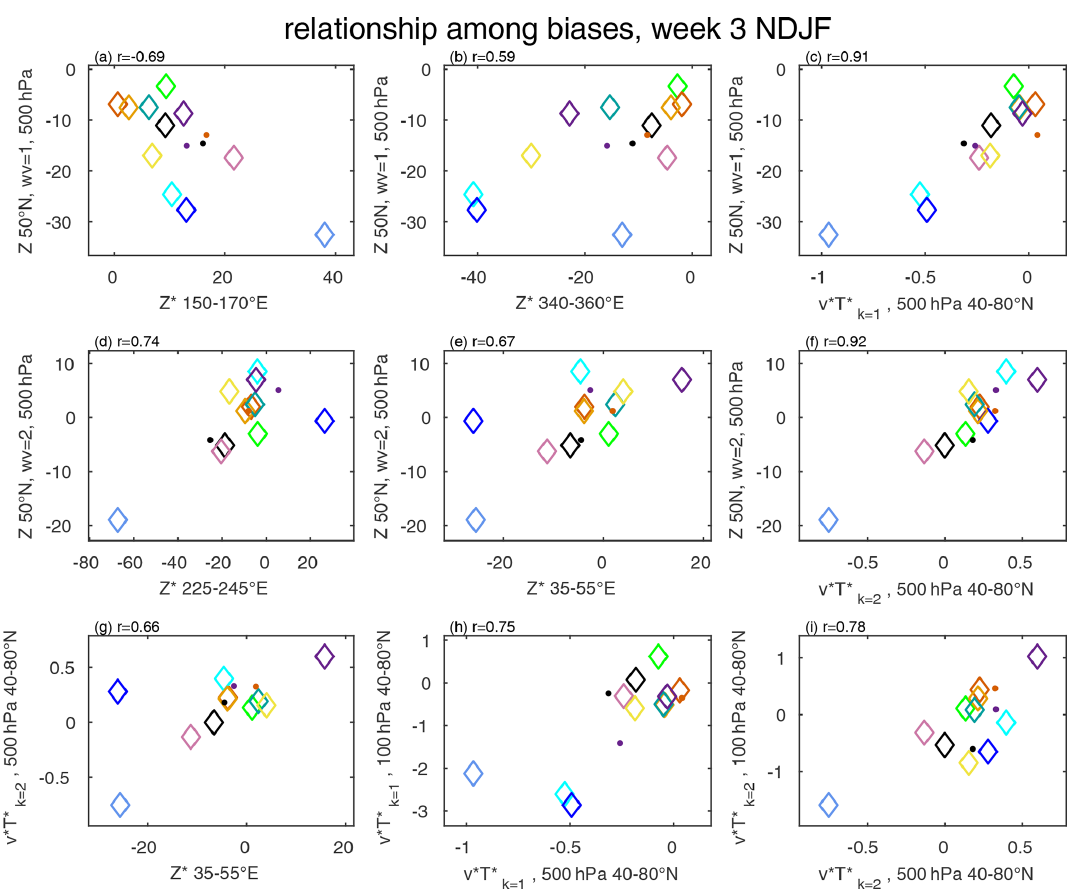
Figure 6. Summary of relationships among the biases in the S2S models during NDJF (the different models are represented by colors similarly to the legend of Fig. 3). Panels (a)–(c) : Z at 50 ◦ N wavenumber 1 and (a) 500hPa Z ∗ over the northwestern Pacific (150–170 ◦ E), (b) 500hPa Z ∗ over the North Atlantic (340–360 ◦ E), and (c) 500hPa mid-latitude (40–80 ◦ N) wavenumber 1 v ∗ T ∗ . Panels (d)–(f) : Z at 50 ◦ N wavenumber 2 and (d) 500hPa Z ∗ over western North America (225–245 ◦ E), (e) 500hPa Z ∗ over western Eurasia (35–55 ◦